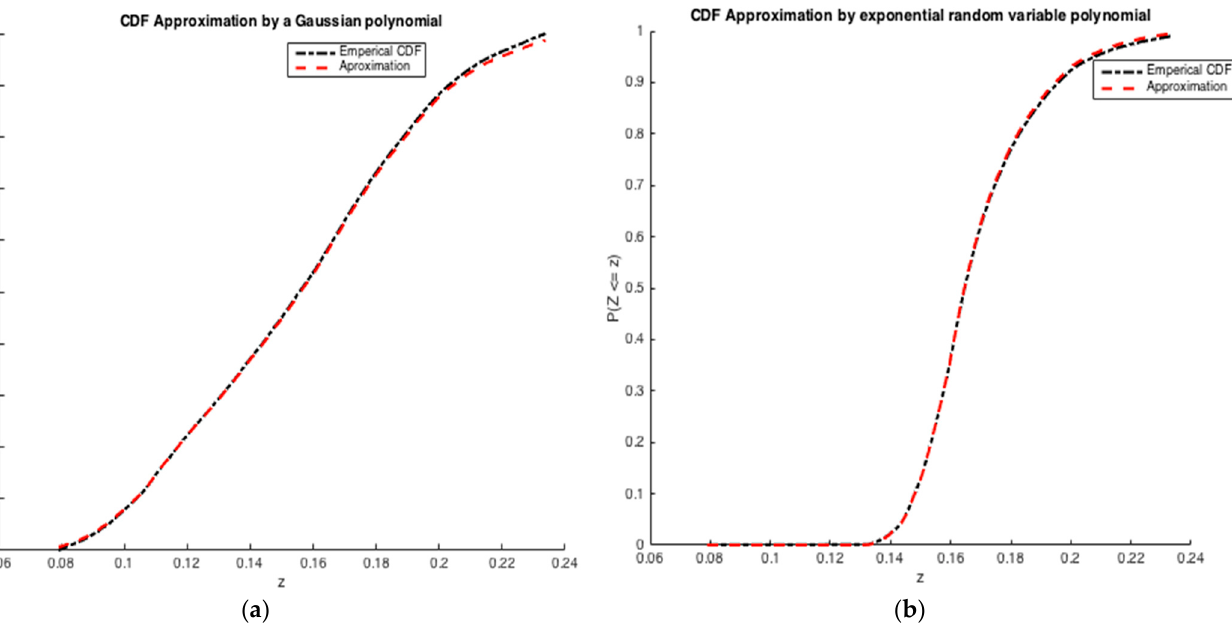
Figure 3. Exponential variable approximated using collocation by: ( a ) a Gaussian polynomial and, ( b ) an exponential random variable polynomial. ( b ) an exponential random variable